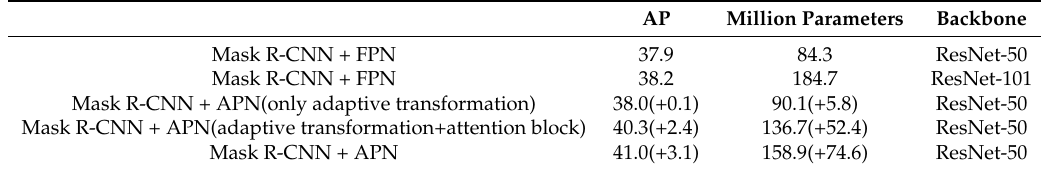
Table 4. Ablation experiments: We trained on trainval35k , tested on val-2017 or test-dev , and report the value of the